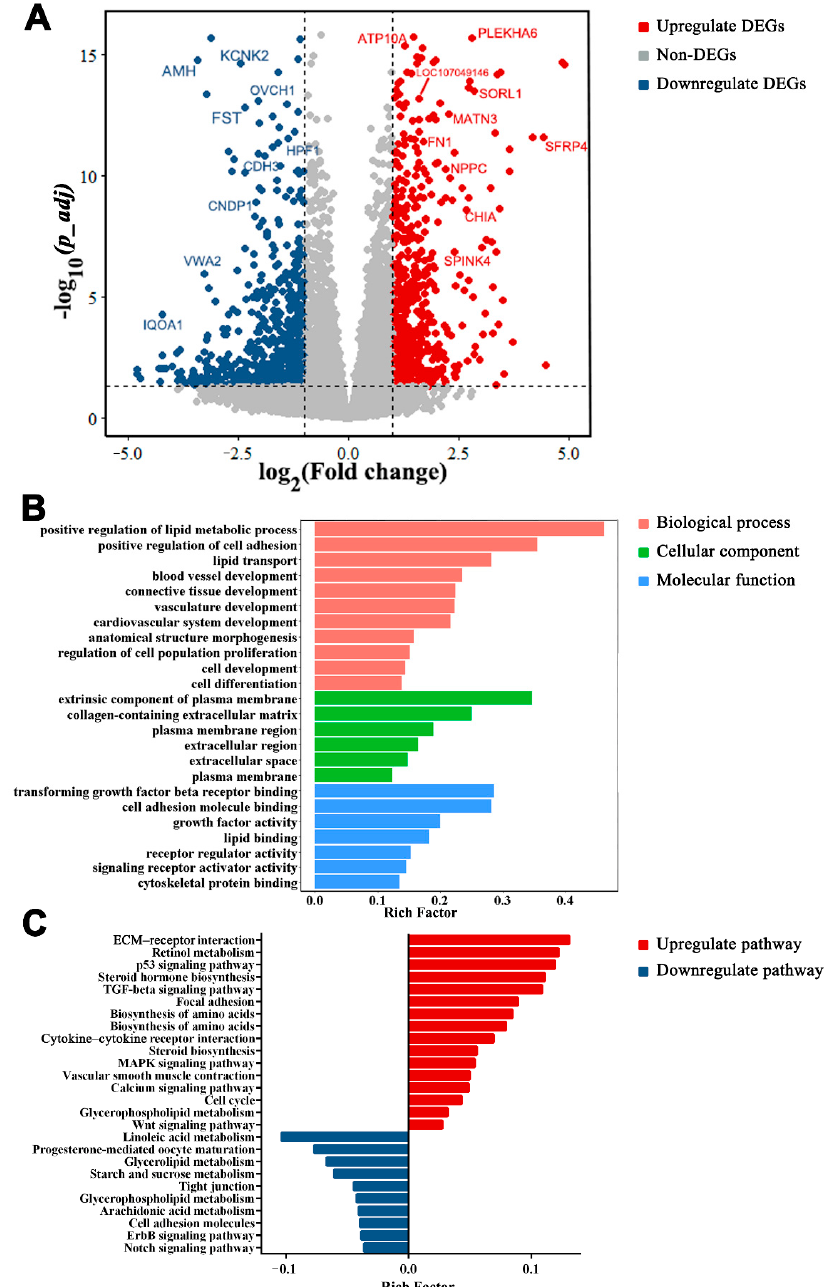
Figure 8. Differentially expressed genes (DEGs) in large white follicles (LWF) vs. large yellow follicles (LYF). ( A ) Volcano map of DEGs in LWF vs. LYF. DEGs with p_adj < 0.05 and log (cid:2870) fold change ≥ 1 are marked in red, and DEGs with p_adj < 0.05 and log (cid:2870) fold change ≤ − 1 are marked in blue. ( B ) Gene Ontology functional classification of DEGs in biological process, cellular component, and molecular function categories. ( C ) Kyoto Encyclopedia of Genes and Genomes pathways of DEGs.